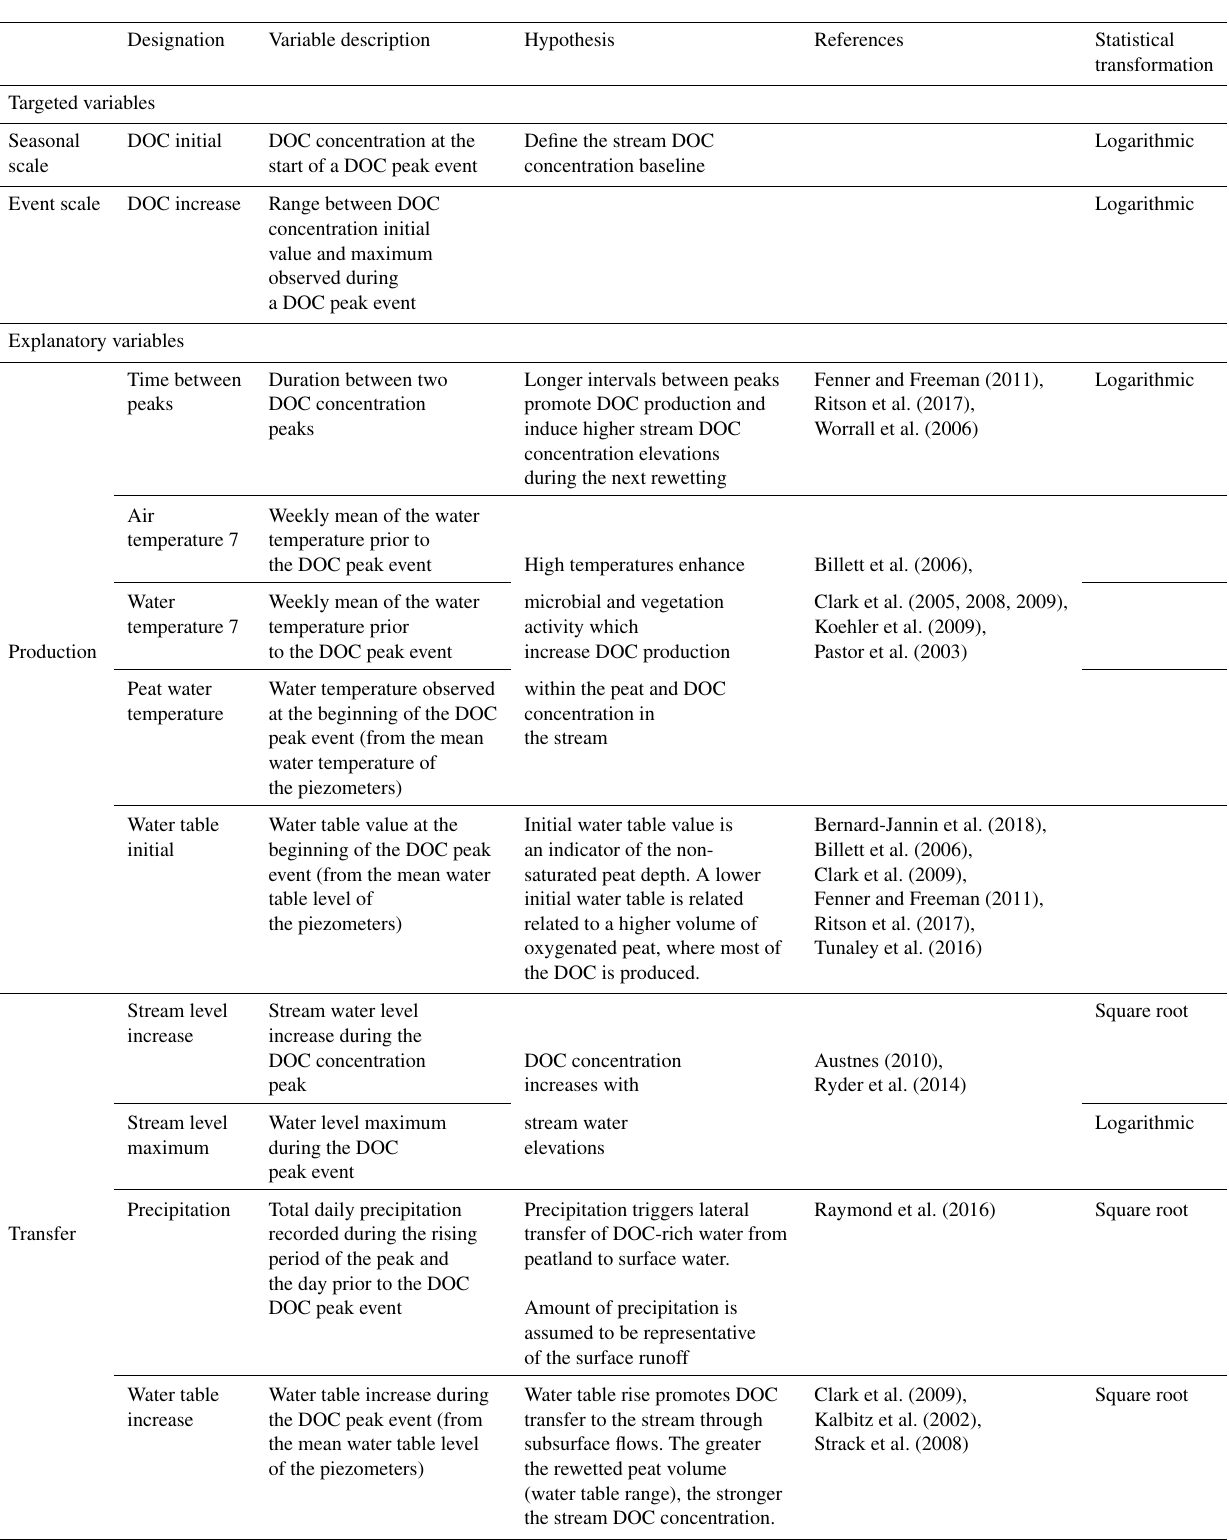
Table 1. Targeted and explanatory variable